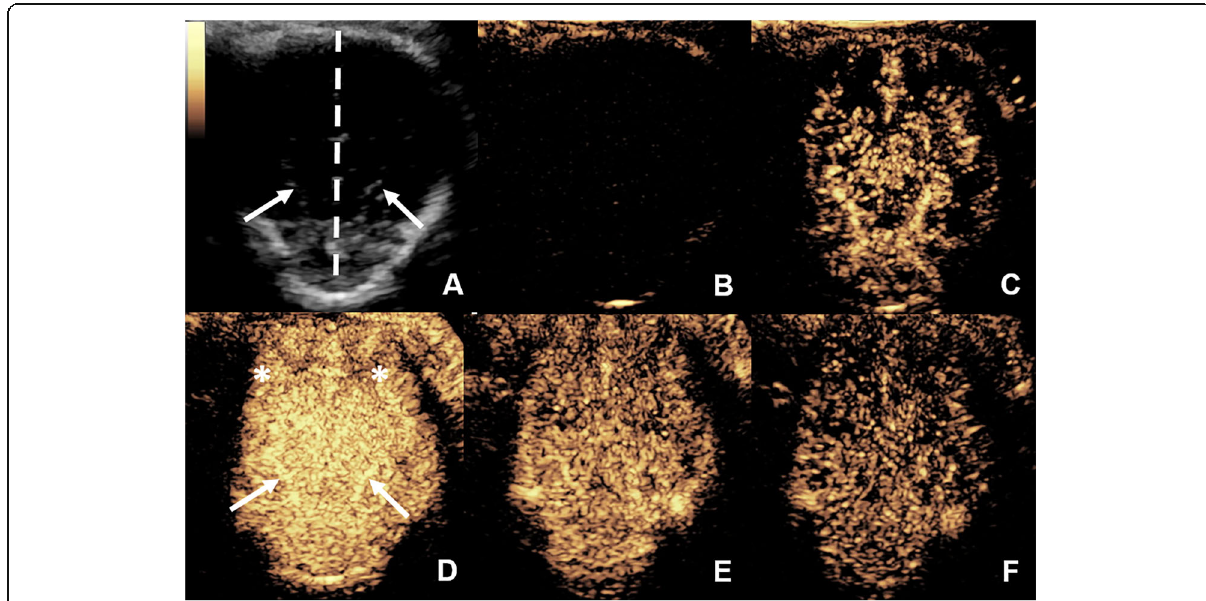
Fig. 3 In utero contrast-enhanced ultrasound examination through the fetal brain in a coronal plane with a , grayscale image for localization including thalami (arrows), brain parenchyma (asterisks), and midline denoted by the dotted line and b , baseline image optimized for contrast